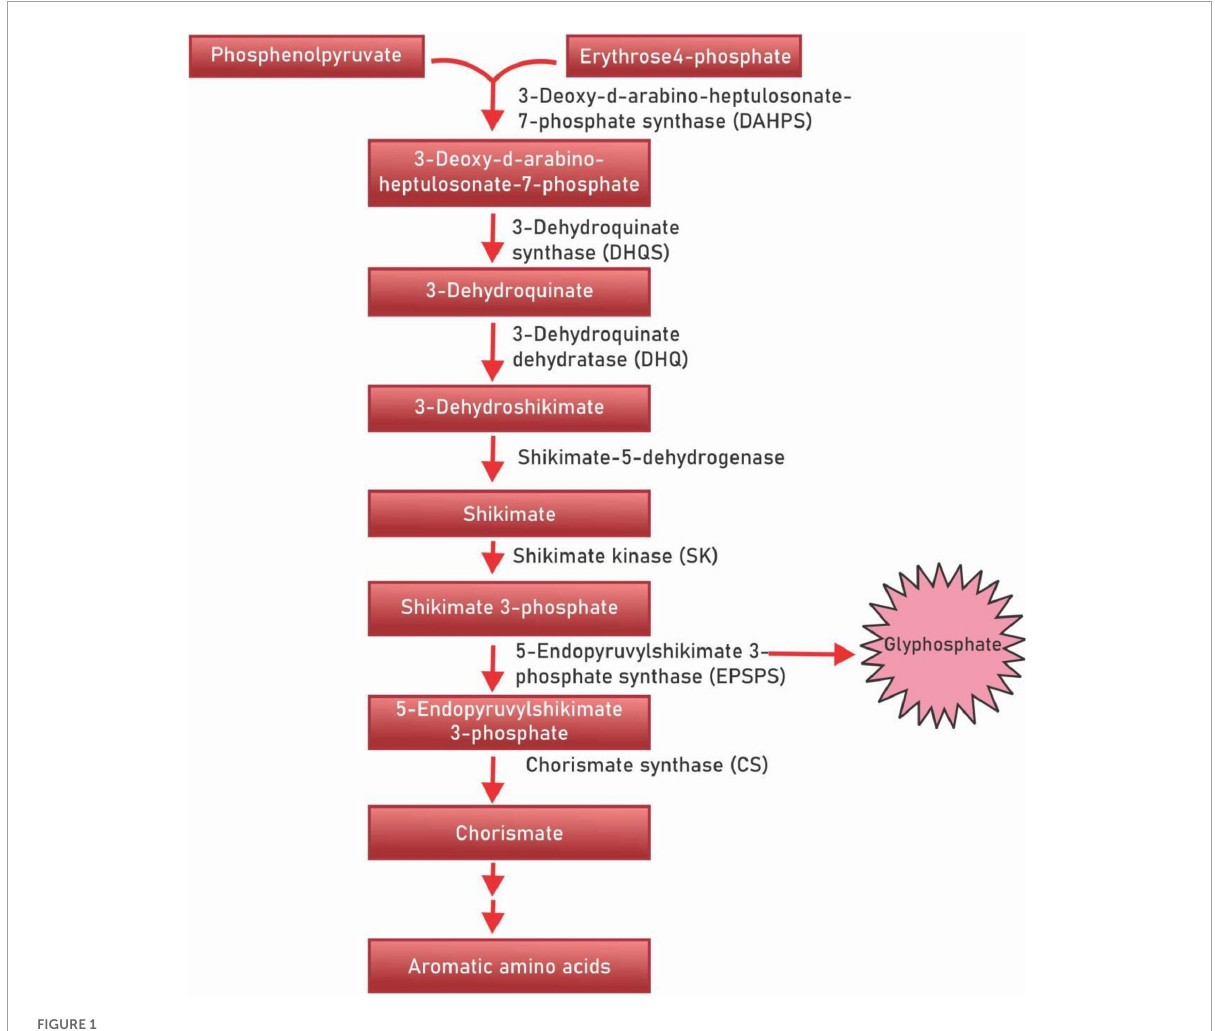
FIGURE1 Shikimic acid